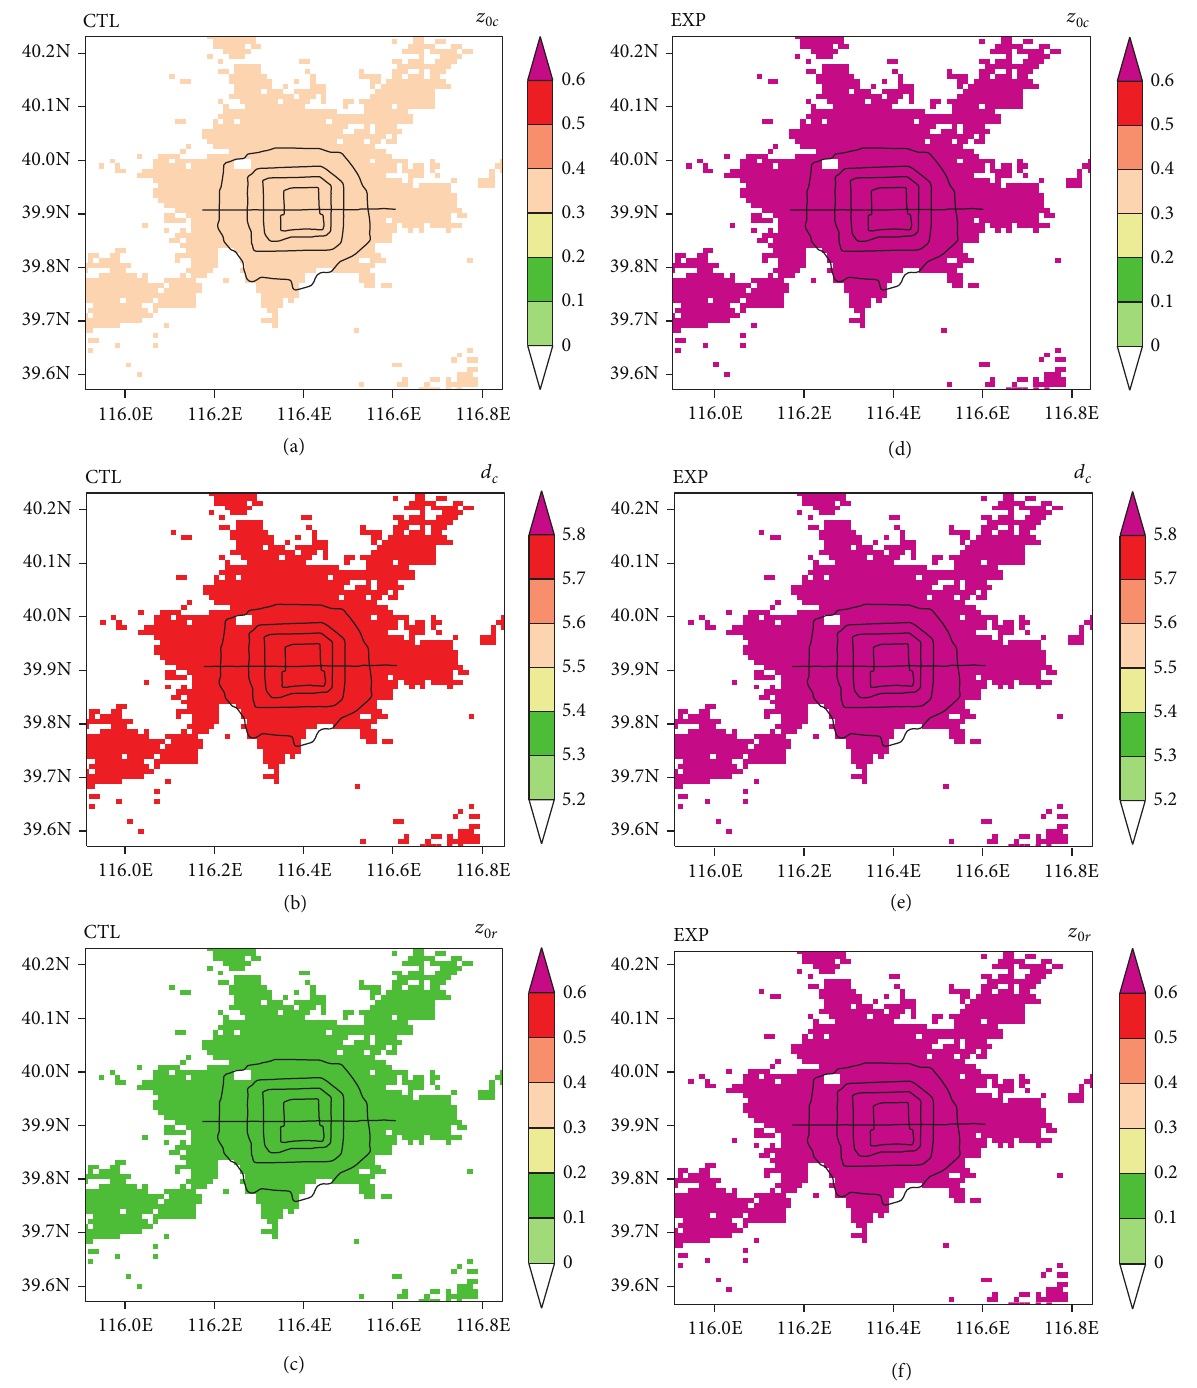
Figure 3: Spatial distribution of the three roughness parameters ( 𝑧 0𝑐 , 𝑑 𝑐 , and 𝑧 0𝑟 ) in the two numerical experiments: (a) 𝑧 0𝑐 in the CTL run, (b) 𝑑 𝑐 in the CTL run, (c) 𝑧 0𝑟 in the CTL run, (d) 𝑧 0𝑐 in the EXP run, (e) 𝑑 𝑐 in the EXP run, and (f) 𝑧 0𝑟 in the EXP run.